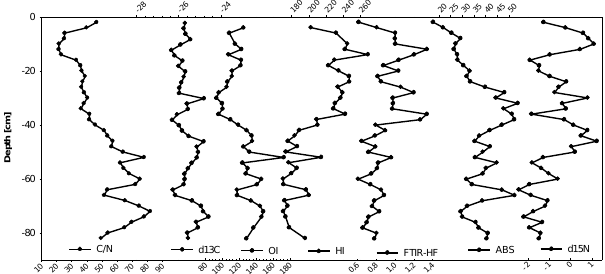
Figure 3. Records of decomposition proxies C/N ratios, δ 13 C(‰) in bulk peat, oxygen and hydrogen indices (OI, HI Figure 3: Records of decomposition proxies C/N ratios, δ 13 C (‰) in bulk peat, oxygen and 2 (mgCO 2 g − 1 TOC)) determined by Rock Eval ® analyses, FTIR de- hydrogen indices (OI, HI (mg CO 2 g -1 TOC)) determined by Rock Eval ® analyses, FTIR 3 composition index 1630/1053cm − 1 , UV-absorption of NaOH peat- decomposition index 1630/1053 cm -1 , UV-absorption of NaOH peat-extracts and δ 15 N (‰) in 4 extracts and δ 15 N(‰) in bulk peat of the KRB bulk peat of the KRB core. 5